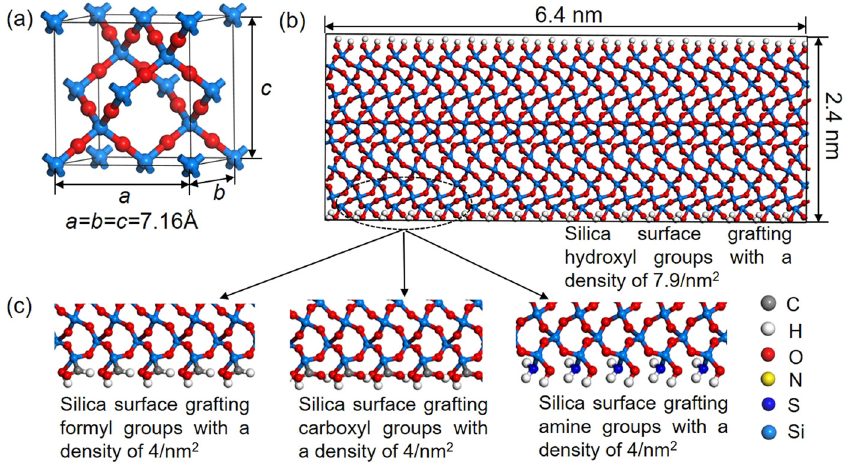
Figure 3: ( a ) The lattice structure of β - cristobalite. ( b ) The initial model of silica where the surface is covered by hydroxyl groups. It is obtained by cleaving on ( 001 ) surface of β - cristobalite and then the dangling oxygen on ( 001 ) surface are statured by hydrogen atoms and dangling silicon atoms are statured by hydroxyl groups. The density of hydroxyl groups on the silica surface is about 7.9/nm 2 . ( c ) The initial models of silica where the surface is covered by formyl group ( COH ) , carboxyl group ( COOH ) , and amine group ( NH 2 ) , respectively. Such structures are obtained by replacing partial hydroxyl groups in ( b ) . The density of these functional groups is about 4/nm 2